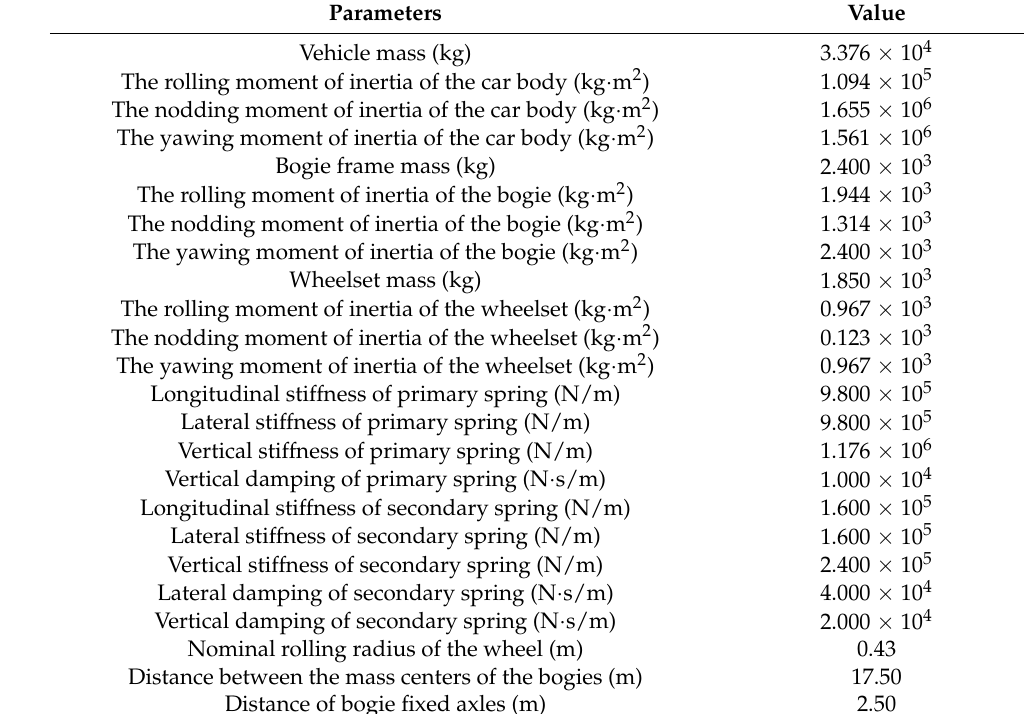
( c ) Figure 4. Critical rail sections and interpolation simulation of turnout: the critical rail sections in ( a ) the switch panel; ( b ) the crossing panel; ( c ) the stock rail and switch rail model.